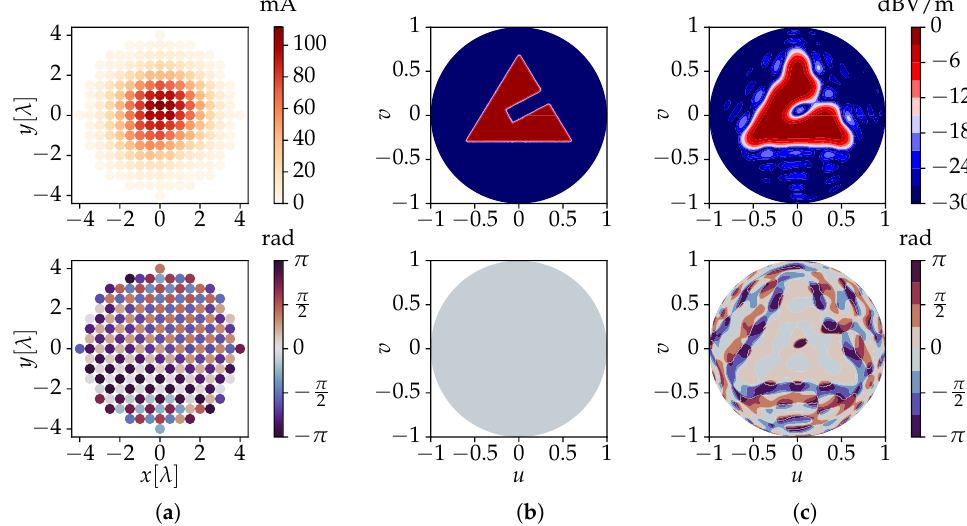
Figure 6. Results for a synthesized planar array consisting of 197 x -polarized dipoles. The figures show the amplitudes ( top ) and phases ( bottom ) of ( a ) the feeding currents obtained by the novel algorithm, for a ( b ) triangle-like shaped target near-field and ( c ) the co-polar electric field solution obtained by the novel method. The results in ( b , c ) are drawn for the upper hemisphere of a target sphere of radius R T = 6 λ , where u = sin θ cos φ and v = sin θ sin φ